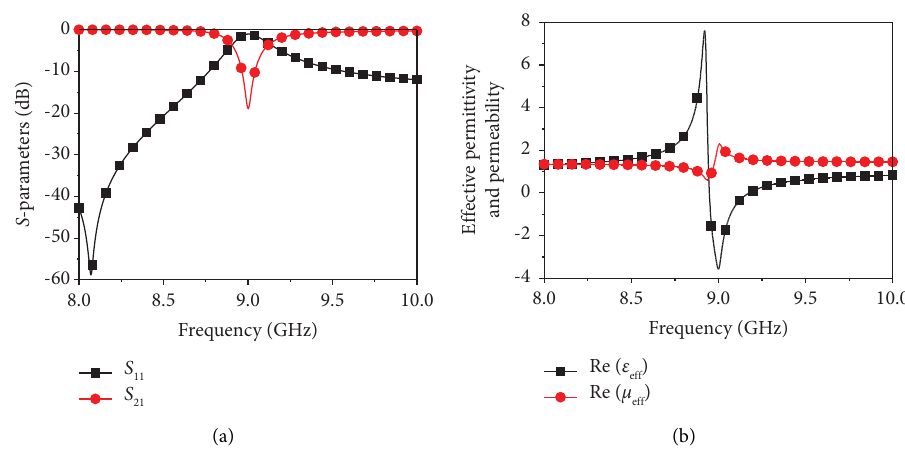
Figure 3: Simulated results of the CSRR. (a) S parameters. (b) Retrieved efective permittivity and permeability. Layer